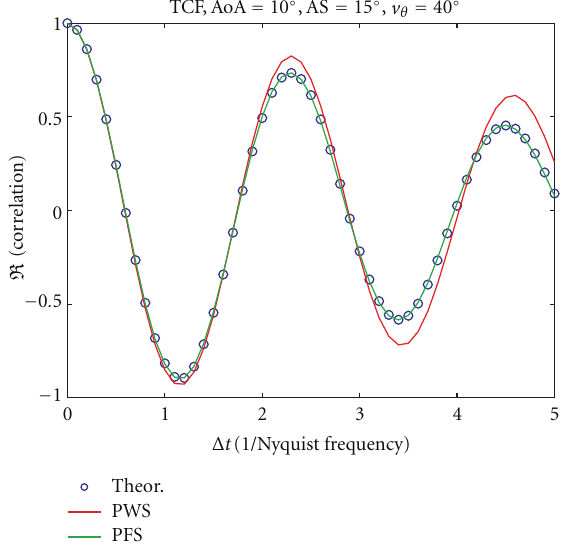
Figure 8: Simulated Doppler power spectra with 16probes, AoA = 10 ◦ , and ASA = 15 ◦ . Figure 9: Simulated temporal correlations with 16probes, AoA